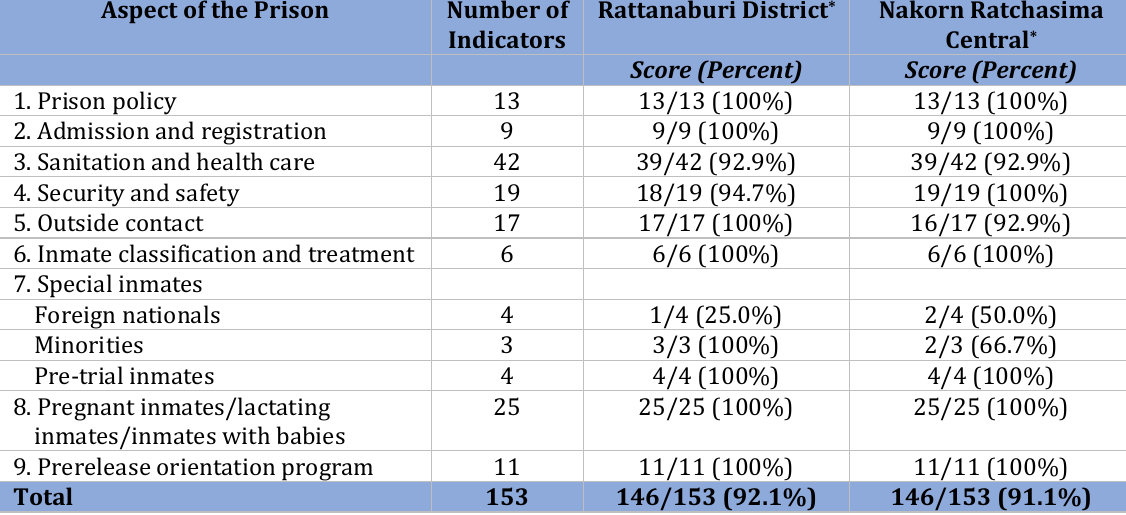
Table 2: Performance of two Thai prisons based on the Bangkok Rules Aspect of the